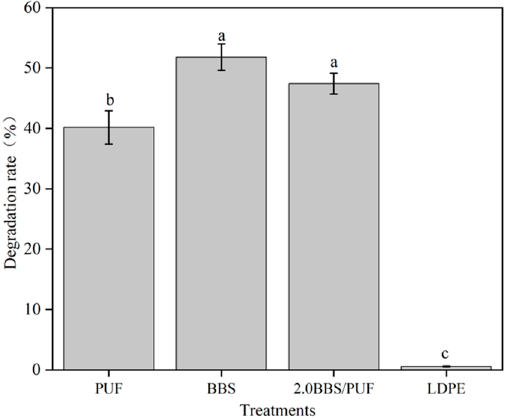
Figure 7. The degradation rate of different mulching films. Error bars represent standard deviations from five replicates. The lowercase letters in the bars indicate significant differences among the treatments (n = 6, p < 0.05).